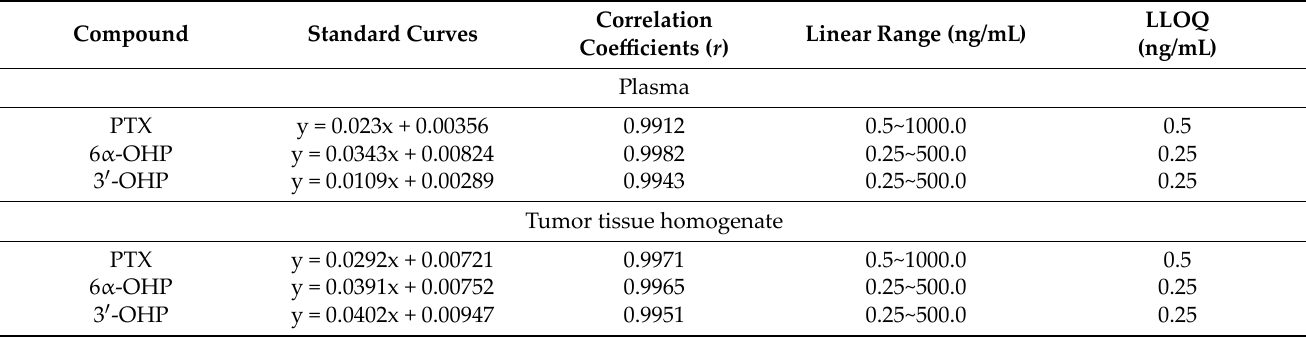
Table 2. Standard curves, correlation coefficients, linear ranges, and